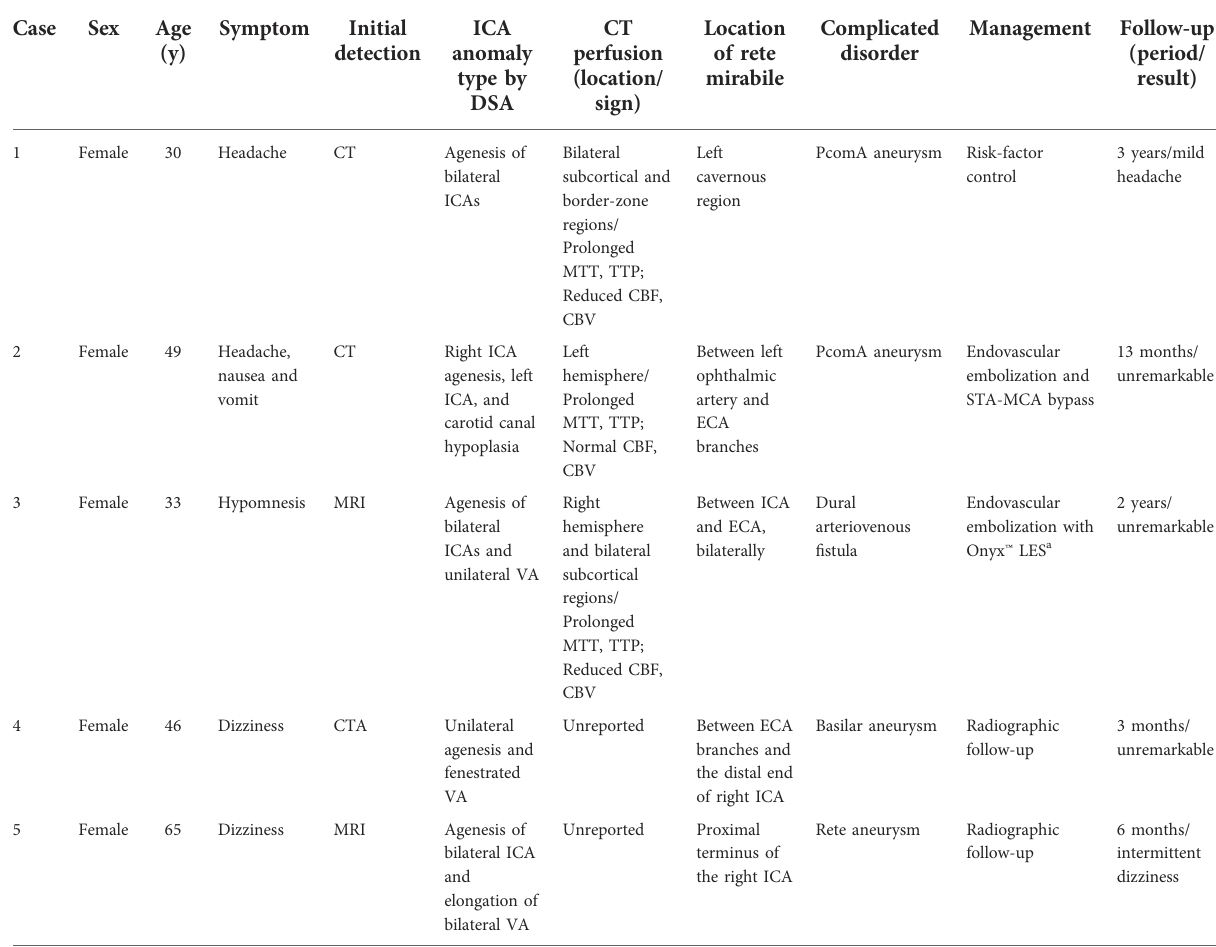
TABLE 1 Patient